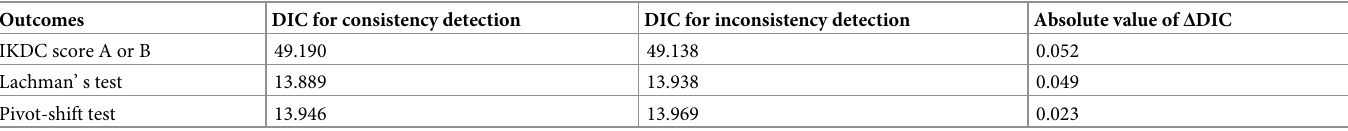
Table 3. Consistency and inconsistency detection for the outcomes.